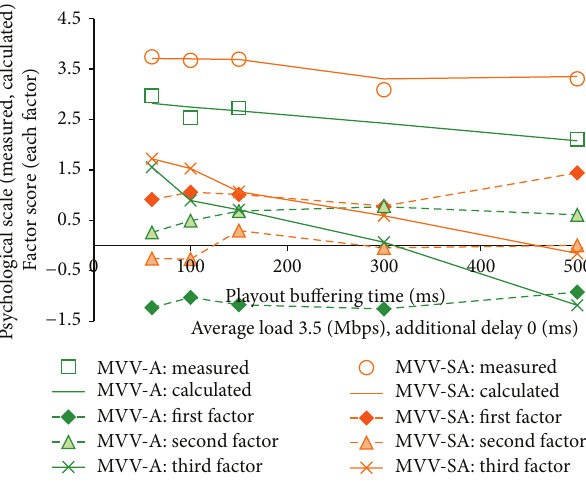
Figure 11: Psychological scale for overall satisfaction and factor